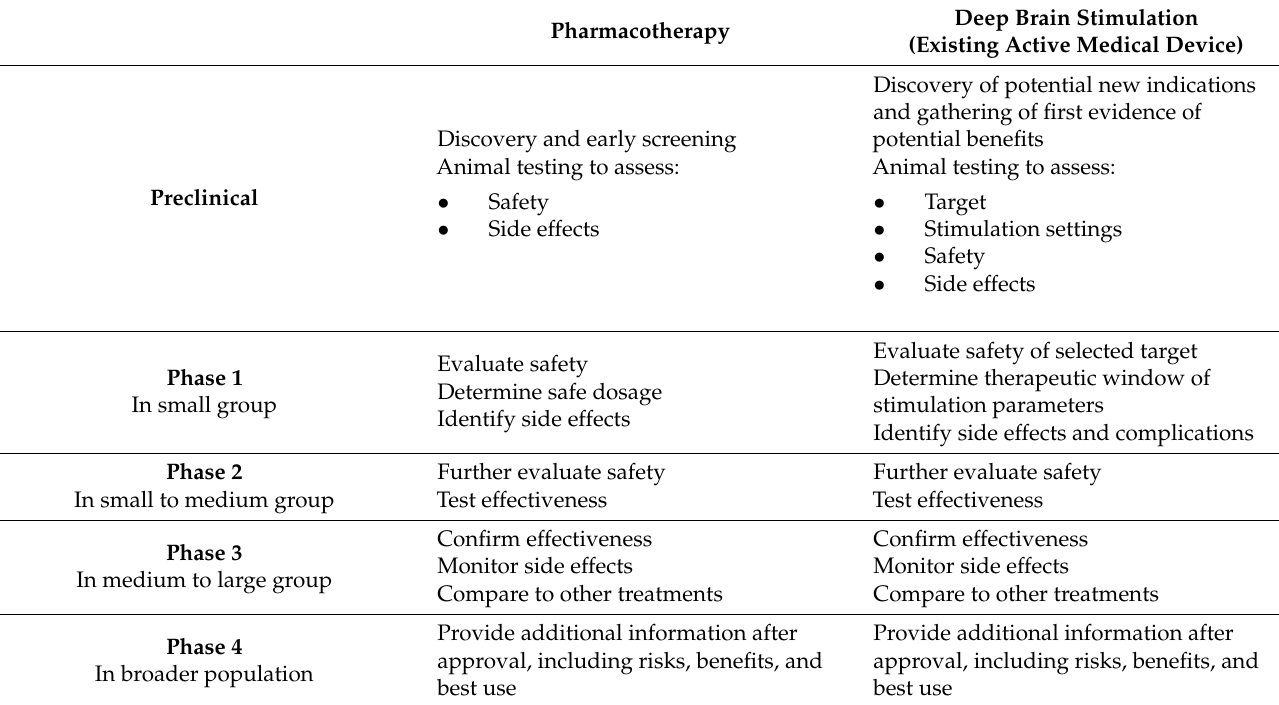
Table 1. Comparison between phases in drug trials and suggested phases in DBS